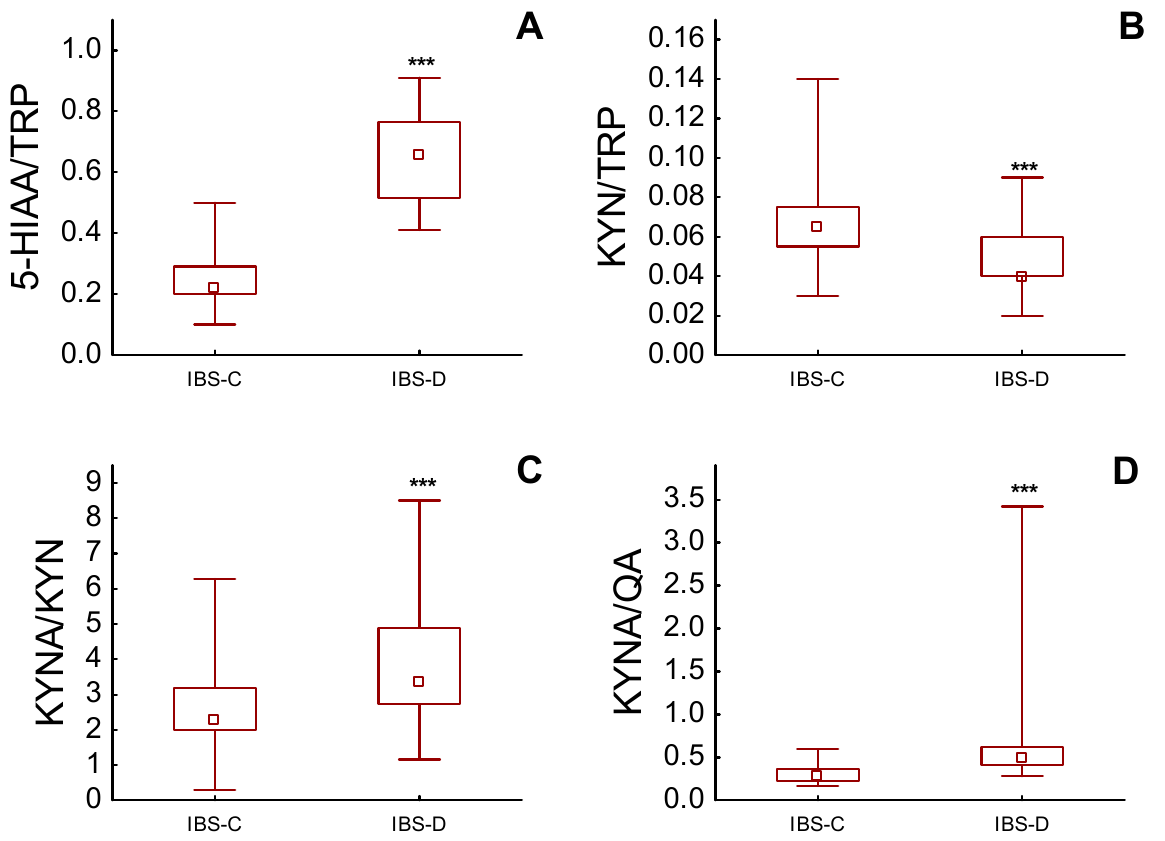
Figure 3. Ratios between urinary levels of ( A ) 5-hydoxyindoleacetic acid (5-HIAA) and tryptophan (TRP), ( B ) kynurenine (KYN) and TRP, ( C ) kynurenic acid (KYNA) and KYN and ( D ) kynurenic acid and quinolinic acid (QA) in patients with constipation-predominant (IBS-C) and diarrhoea- predominant (IBS-D) irritable bowel syndrome; *** p < 0.001. Box and whiskers represent median, IQR and min–max value.